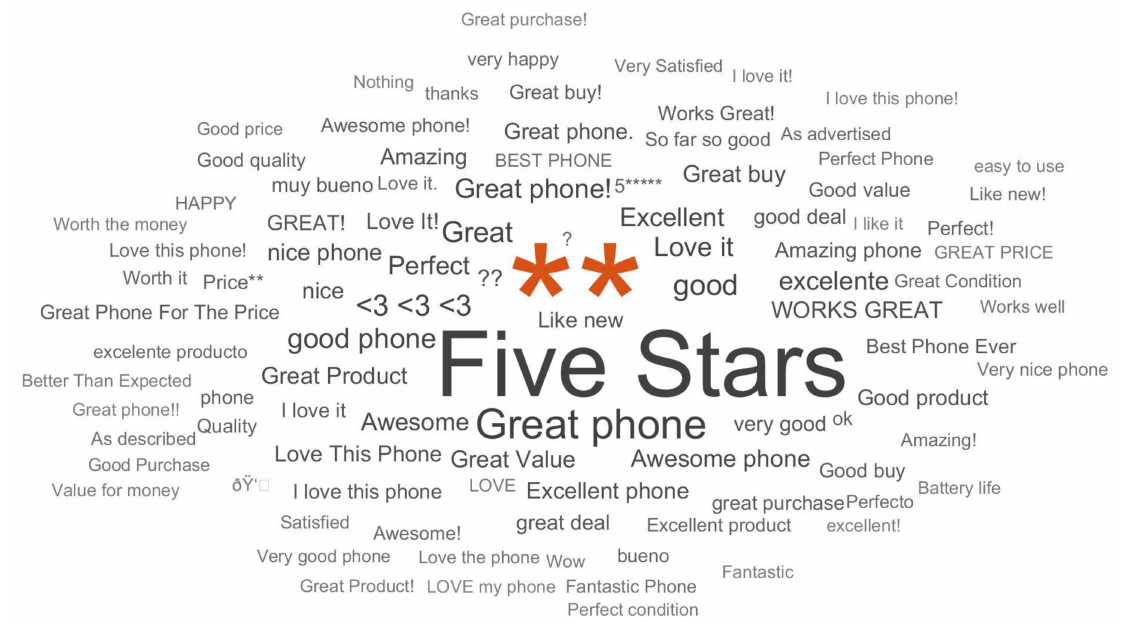
Figure 18. Word-cloud plot analysis for words with review score